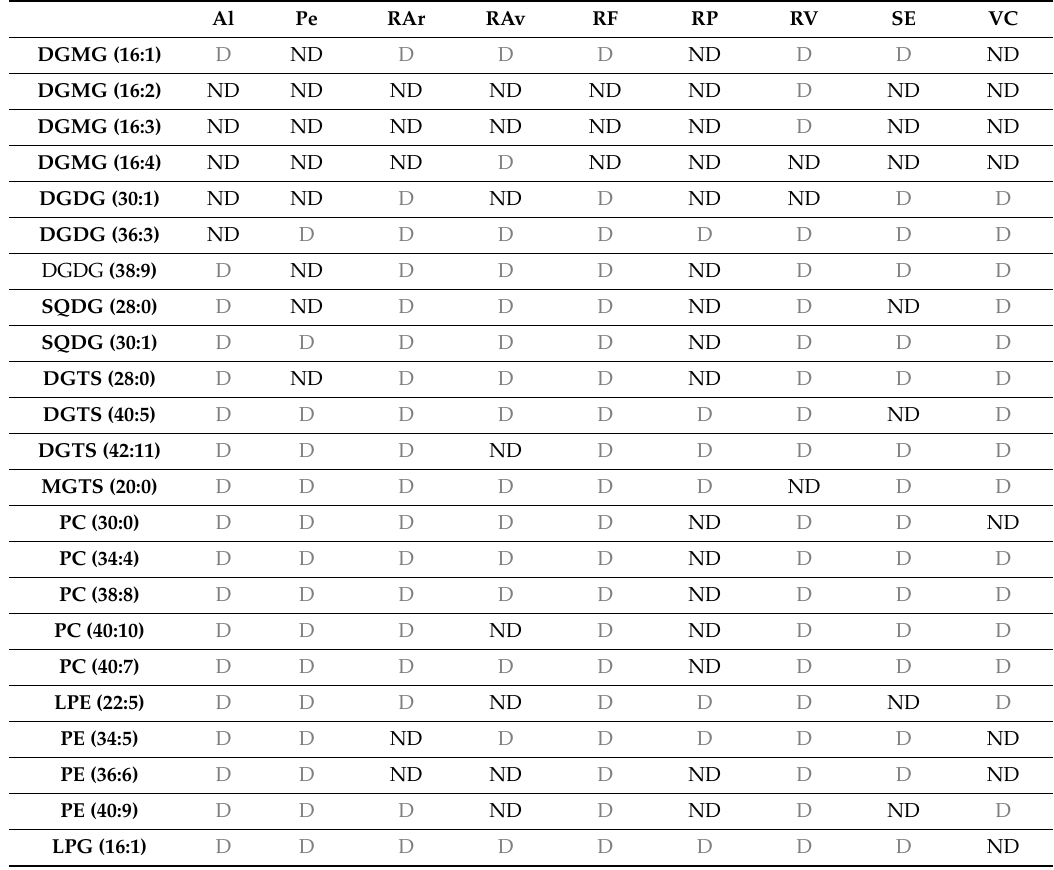
Table 1. Lipid species identified by HILIC–LC–MS in Ulva spp. detected at specific geographic origins: Albufeira (Al), Peniche (Pe), Ria Arousa (RAr), Ria de Aveiro (RAv), Ria Formosa (RF), Ria de Pontevedra (RP), Ria de Vigo (RV), Sado Estuary (SE), and Viana do Castelo (VC). Labels of